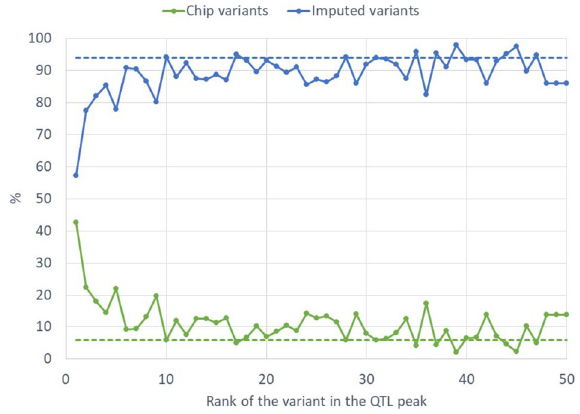
Figure 3. Percentages of chip variants (50 K, HD, or “research” SNPs, in green) and imputed variants (in blue) found among the top 50 variants of QTL peaks. Dashed lines represent the total percentage of chip variants (6%, in green) and imputed variants (94%, in blue) of all variants that were tested in the GWAS.